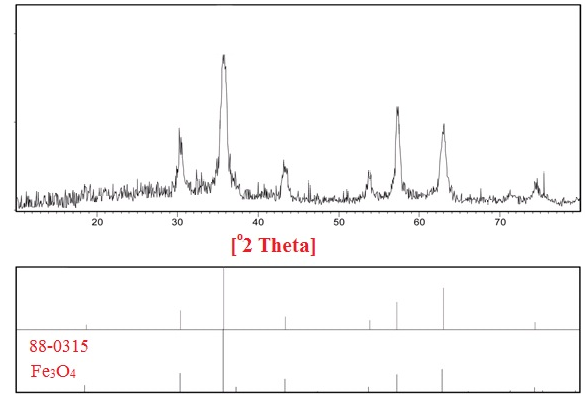
Fig. 2. XRD pattern of magnetite nanoparticles